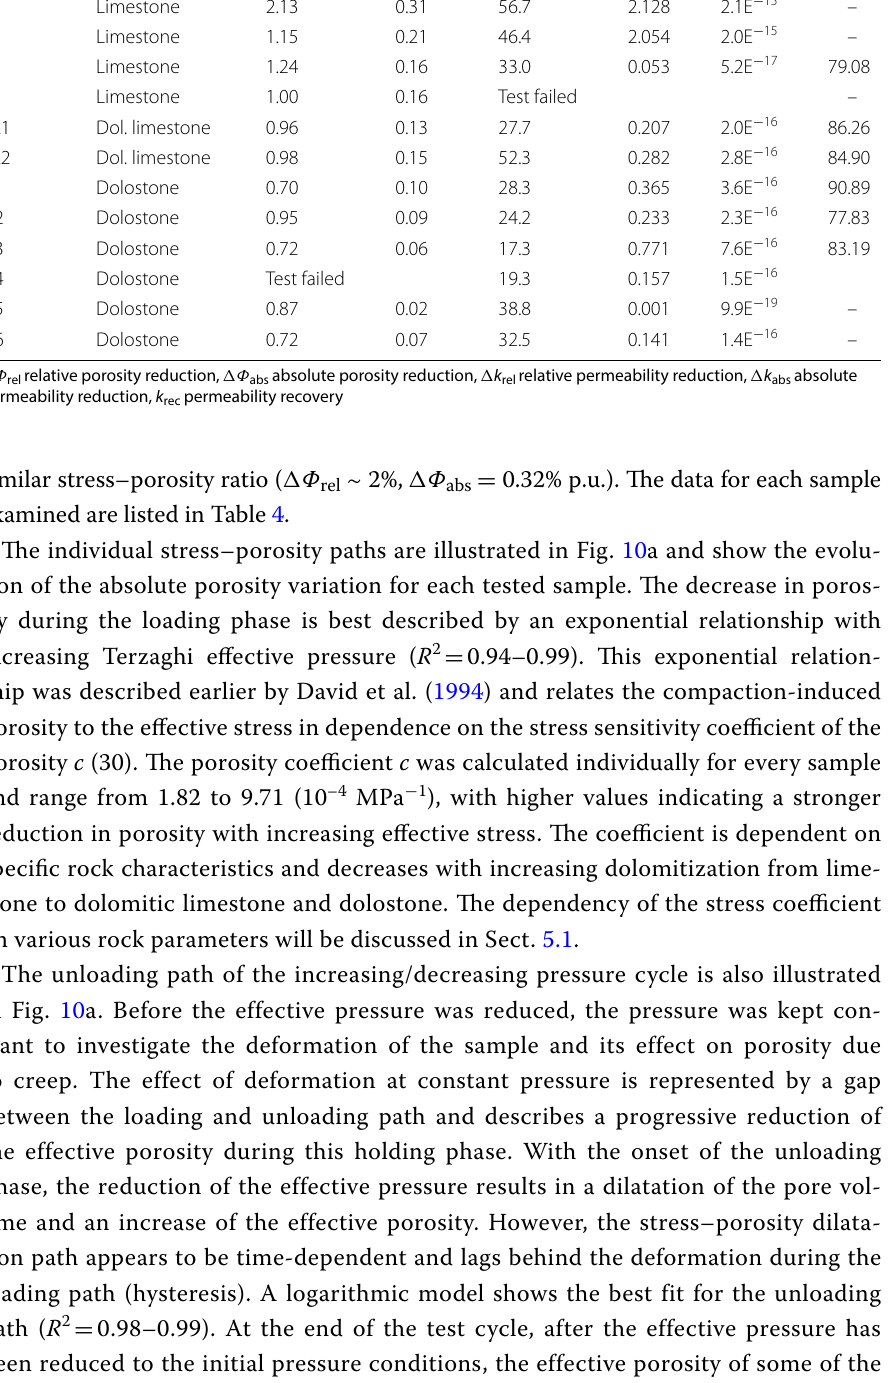
Table 4 Poroelastic parameters resulting from drained hydrostatic tests at an effective pressure of 25 MPa